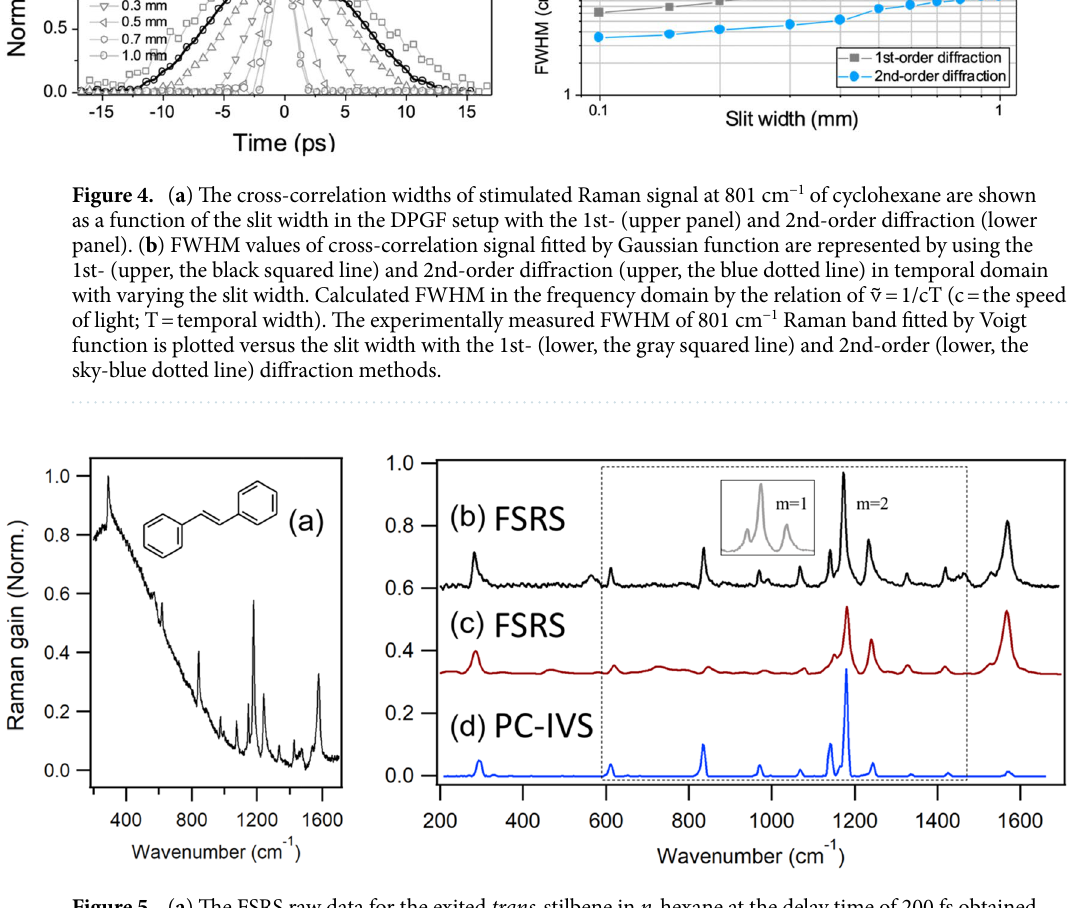
Figure 5. ( a ) The FSRS raw data for the exited trans -stilbene in n -hexane at the delay time of 200 fs obtained by using the 2nd-order diffraction DPGF method. ( b ) FSRS spectrum which is obtained from ( a ) after the background subtraction by the polynomial fit. Inset shows FSRS spectrum of trans -stilbene by using the 1st-order diffraction DPGF method. ( c ) The FSRS spectrum from Ref. 29 . Copyright 2012, American Institute of Physics. ( d ) The PC-IVS spectrum from Ref. 30 . Copyright 2014 American Chemical Society. The shoulders in ( c ) are distinctly resolved in ( b ) and ( d